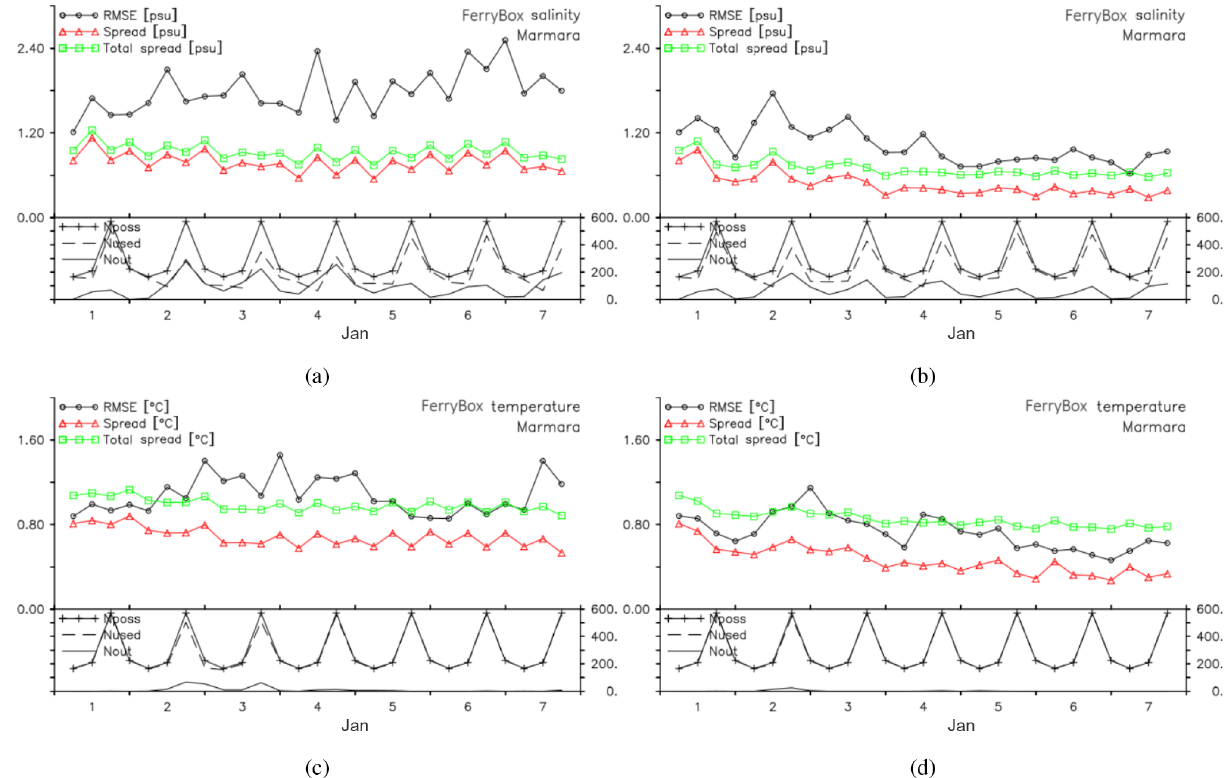
Figure 8. Time series of prior RMS of innovations, spread, and total spread of salinity (a, b) and temperature (c, d) for FB001 (a, c) and FB002 (b, d) . The statistics are computed in the location of the observations used in the corresponding assimilation cycle. The spread is the square root of the variance. Total spread is the square root of the observational error added to the variance. Vertical axis shows the range of each statistics indicated in the legend. Bottom panel of each figure shows the number of available observations ( N poss ) in each assimilation cycle. For the assimilation experiment, FB002, N used and N out show the number of assimilated observations and outliers, respectively. For the experiment without assimilation, FB001, they are the number of observations that would be assimilated or rejected, respectively, in that specific assimilation cycle if assimilation was